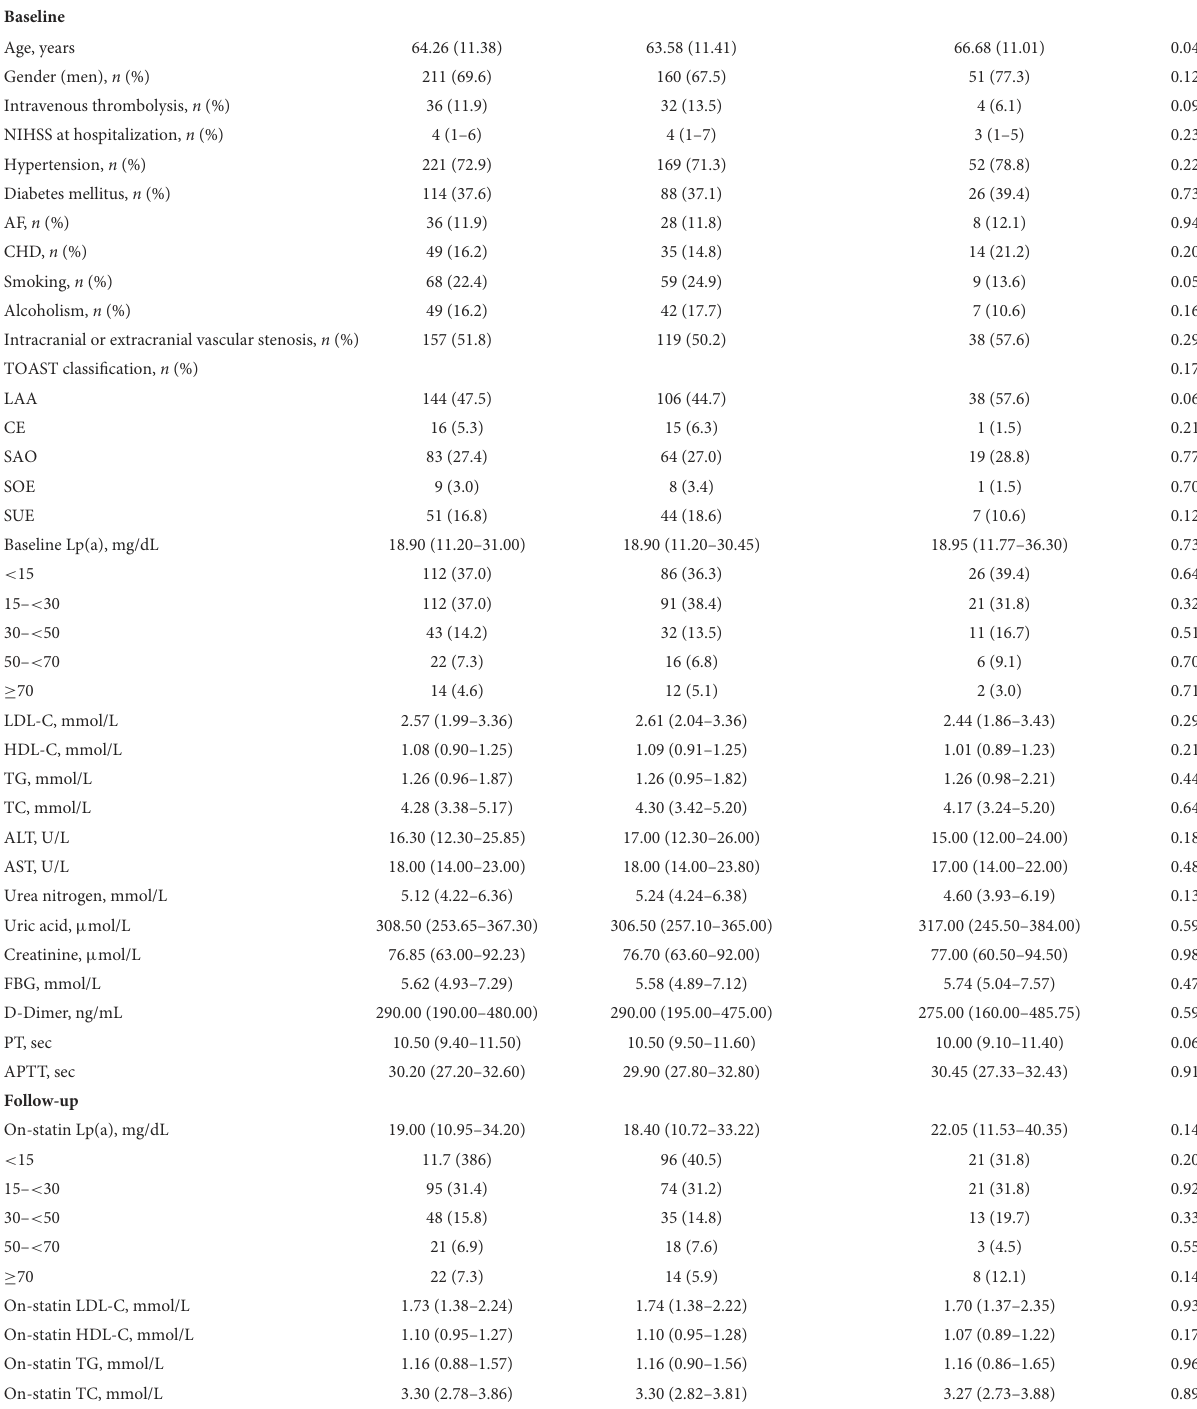
TABLE 1 Baseline and follow-up characteristics of patients in the study cohort. Total ( n = 303) Free-event patients ( n = 237) Patients with end points ( n =